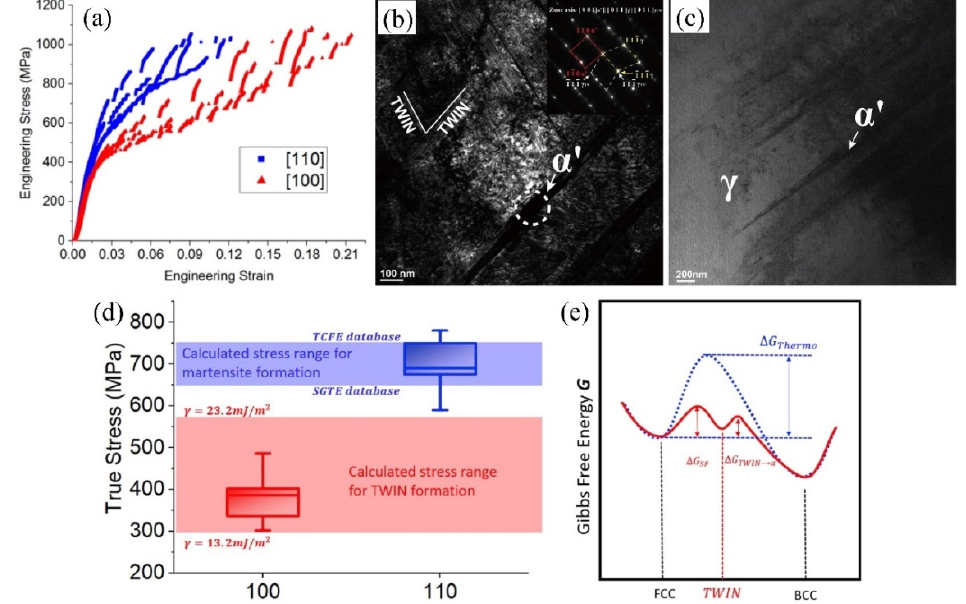
Figure 9. ( a ) Engineering stress–strain curves of the austenitic pillars with different orientations in medium Mn steel (Fe-9Mn-0.6C in wt.%). TEM images show the microstructure in deformed austenitic pillars with the orientation of ( b ) [100] and ( c ) [110]. The nucleation process of the martensite at the intersection of the stacking faults/twins in the micron-pillars with the orientation of [100]. ( d ) The calculated critical stress for triggering the deformation twins and martensite. ( e ) Schematic illustration of the different transformation pathways in the micro-pillars with varied orientations [86,87]. Reprinted with permission from ref. [87]. Copyright 2019, Elsevier.